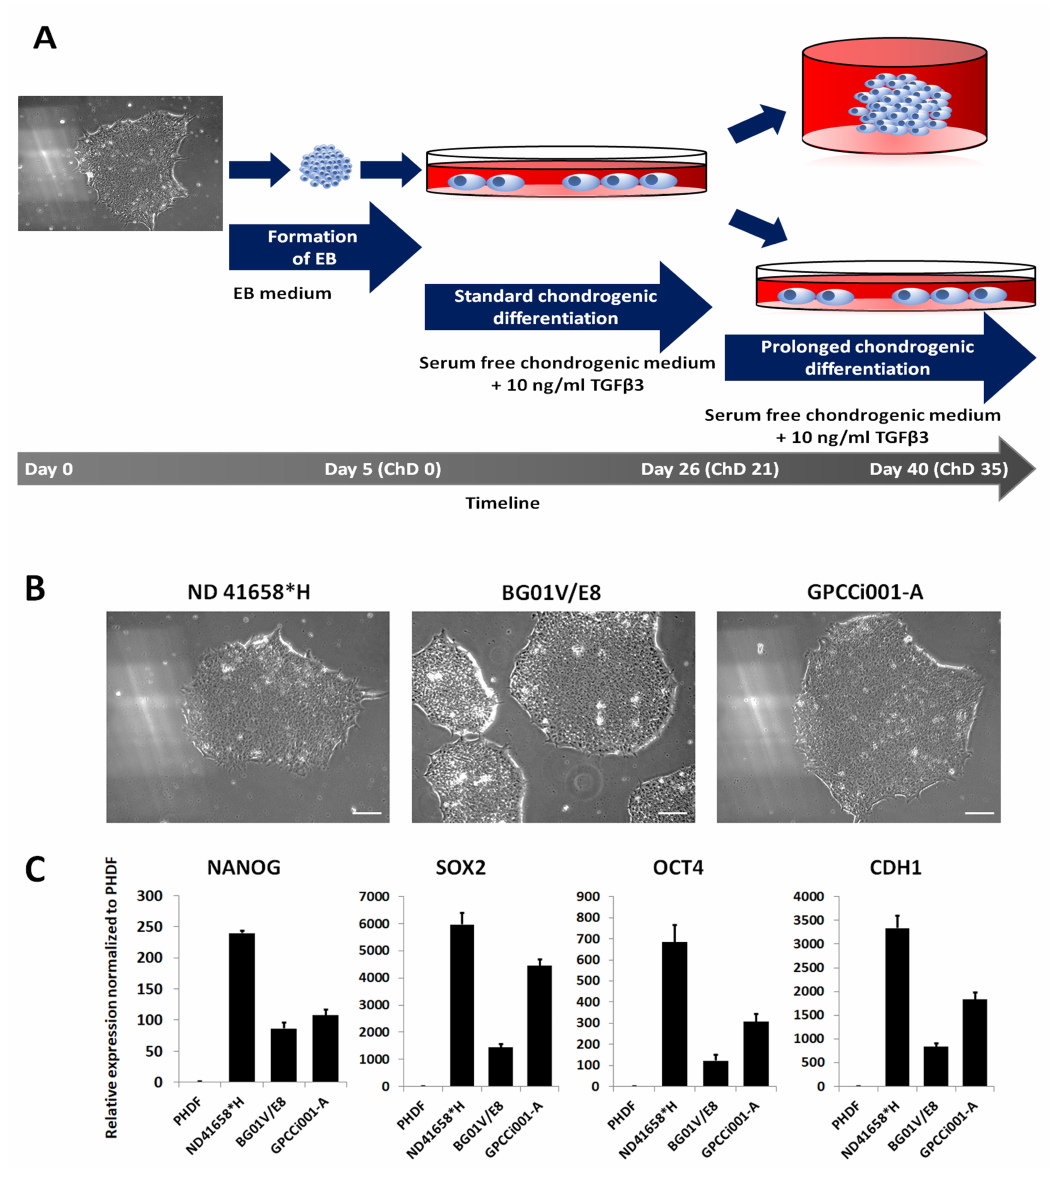
Figure 1. The scheme of the experiment and adaptation of pluripotent cell lines in serum- and feeder-free conditions. ( A ) Pluripotent stem cells (colony of cells, magnification 100 × ) undergo formation of EBs for five days in suspension culture. The formed EBs were then transferred onto Matrigel ™ coated plates for the standard 3-week di ff erentiation in serum-free conditions with supplementation of TGF β 3. The prolonged time of di ff erentiation was used to establish an influence on chondrogenesis. Additionally, 3D culture was performed to compare its e ff ect on di ff erentiation and maturation of chondrogenic like-cells. ( B ) The morphology of pluripotent stem cells adapted to serum- and feeder-free conditions shows that the colonies formed from compacted cells with a high rate of the nucleus to cytoplasm ratio. The white scale bar represents 50 µ m. ( C ) The expression of pluripotency markers in adapted pluripotent cell lines indicates their increased expression in comparison with